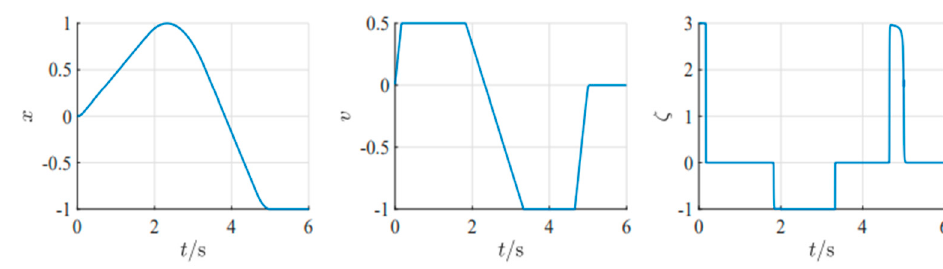
Figure 6. Variation curves of ATD signal vs. time.